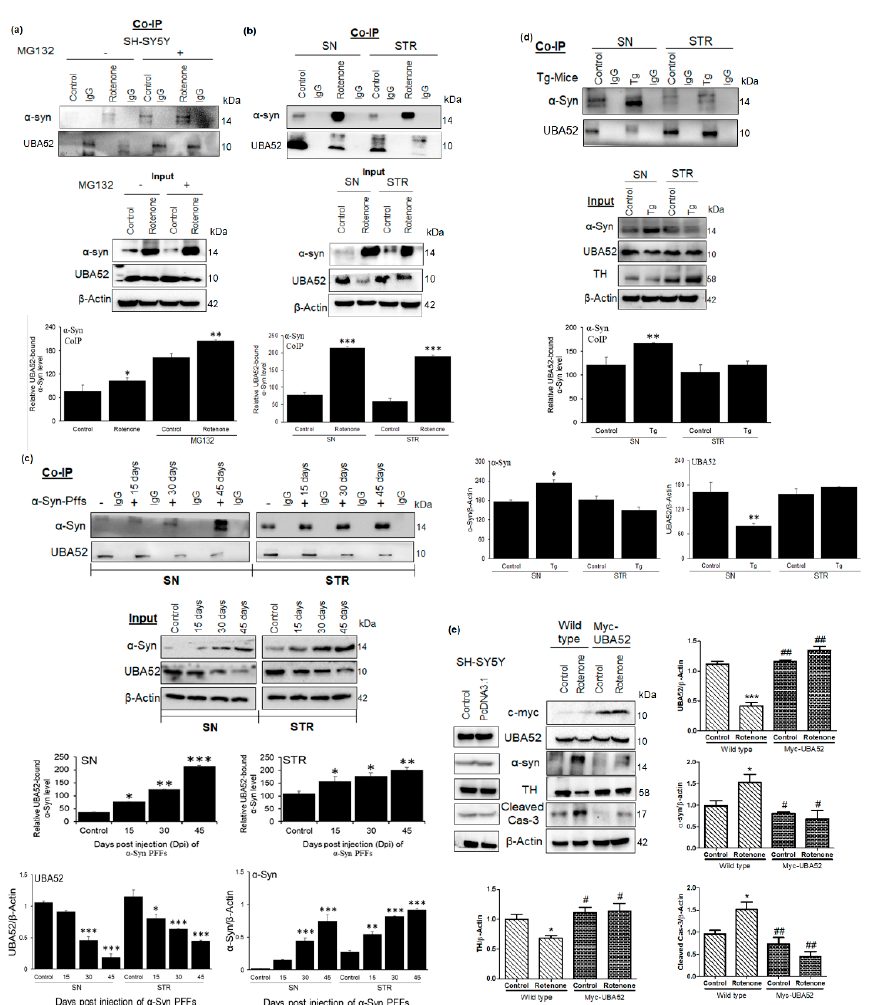
Figure 2. UBA52 interacts with α -Syn, and its over-expression in SH-SY5Y cells deter the alteration in PD markers protein abundance, preventing the disease onset. Co-IP (Protein A Sepharose beads attached to the anti-UBA52 antibody/anti-IgG antibody) was performed, and the cell or tissue lysates were incubated with the antibody-beads complex, following which the beads were boiled with 2X-reducing buffer, centrifuged and the supernatant was resolved on a 4–16% gradient SDS- PAGE to detect the interacting proteins. ( a , b ) Representative images and analysis depicting the in vitro interaction of UBA52 and α -syn, against IgG as a negative control in SH-SY5Y cells with or without rotenone& MG132 treatment; and control& rotenone treated PD-related SN and STR region, respectively; rats used per group in each replicate = 4; n exp = 4. ( c ) Representative image and analysis depicting the Co-IP experiment to check the interaction of UBA52 and α -Syn, against IgG as a negative control in PBS-administered control& mouse recombinant α -Syn PFF treated PD-related SN and STR region, respectively at 15-, 30- and 45-days post-injection (dpi) to show the underlying mechanism of UBA52 in regulating α -Syn abundance; rats used per group per replicate = 5; n exp = 3. ( d ) Representative image and analysis depicting the Co-IP experiment to check the interaction of UBA52 and α -Syn, against IgG as a negative control in the PD-related SN and STR region of the control C57BL mice and the C57BL/6J-Tg (Th-SNCA*A30P*A53T) 39Eric/J transgenic (Tg) mice, respectively; mice used per group per replicate = 5; n exp = 2. ( e ) PcDNA3.1 or Myc-UBA52 transfected SH-SY5Y cells with or without rotenone treatment were immunoblotted for PD-related protein markers; n exp = 3. Quantification is the mean and SEM of at least three independent experiments, and statistical analysis was performed using two-way ANOVA, followed by Tukey’s multiple comparison test. * p < 0.05, ** p < 0.01, *** p < 0.001 control vs. Rotenone/ α Syn PFFs/Transgenic (Tg); # p < 0.05, ## p < 0.01, ### p < 0.001 Myc-UBA52 vs. Rotenone.